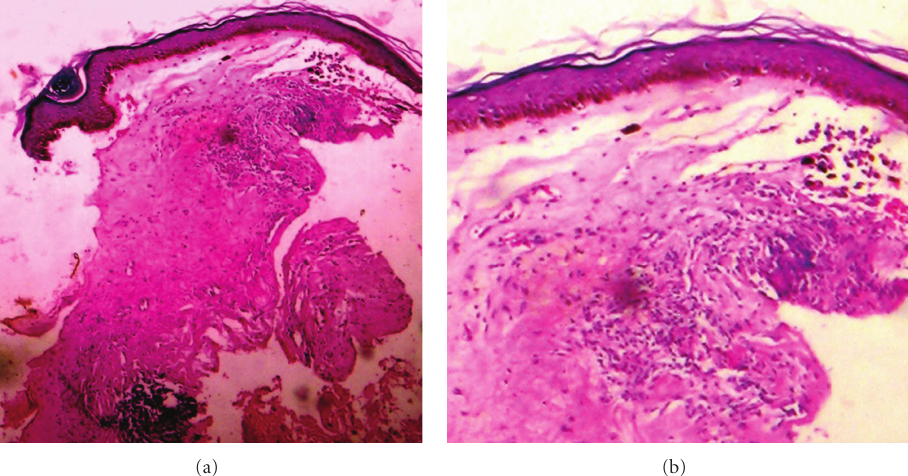
Figure 2: Hyperkeratotic scale with follicular plugging and atrophic epidermis. Sub-epidermal zone of pallor (edema) and scattered inflammatory